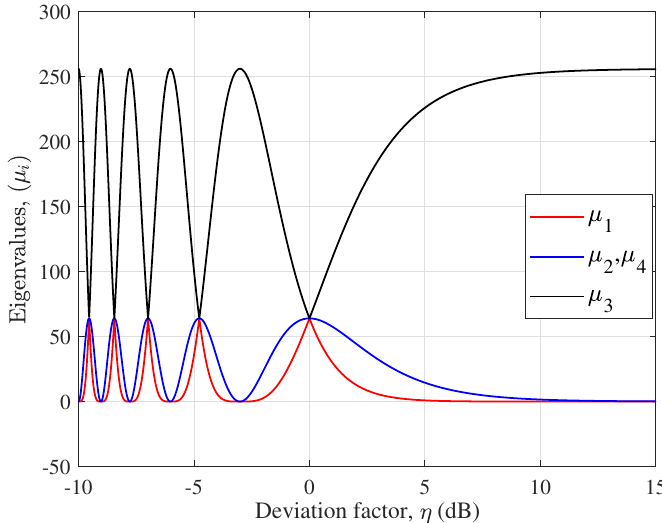
Figure 4. { µ i } as a function of η in dB when H = H LOS .